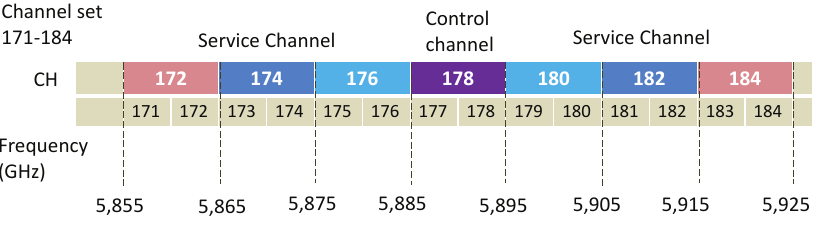
Figure 1. Spectrum allocation in IEEE